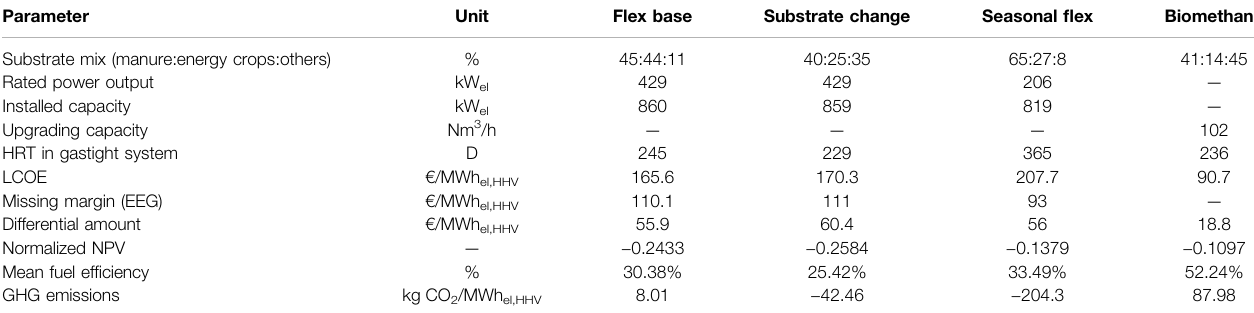
TABLE 7 | Effect of the follow-up concept on the characteristic parameters and key performance indicators of BGP4 in the REF scenario. Parameter Unit